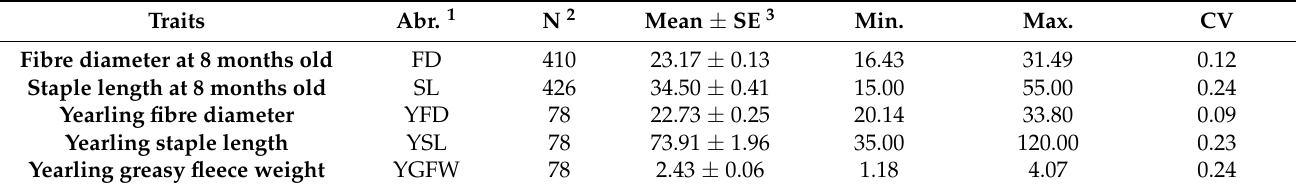
Table 1. Descriptive statistics of wool